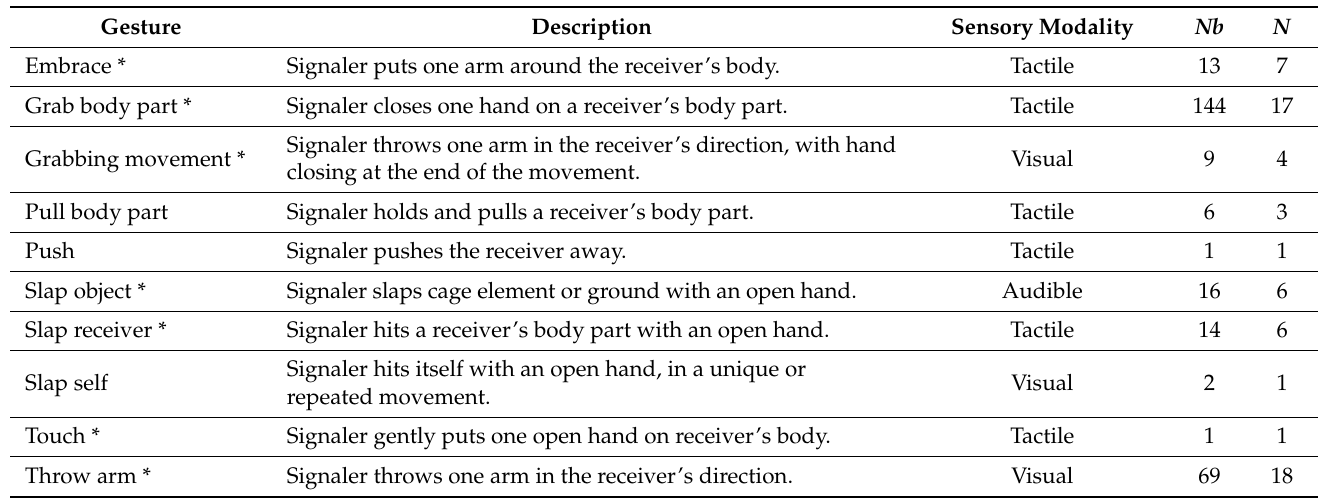
Table 3. Manual gestures observed in captive red-capped mangabeys (adapted from Reference [70]). Nb : number of instances; N : number of different signalers; *: previously described as intentional